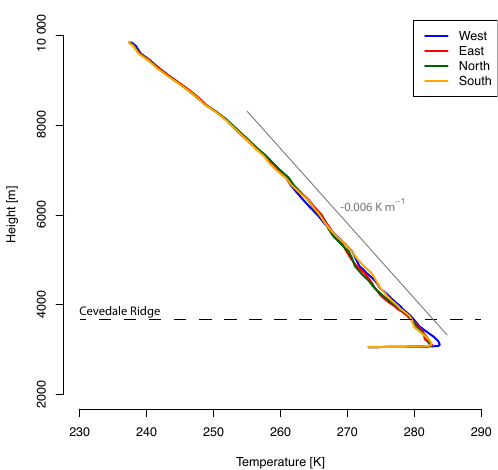
Figure 5. Vertical temperature profiles at location Z2 for each ex- periment. The dashed line indicates the altitude of the Cevedale ridge. The grey solid line represents a lapse rate of − 0.006Km − 2 .